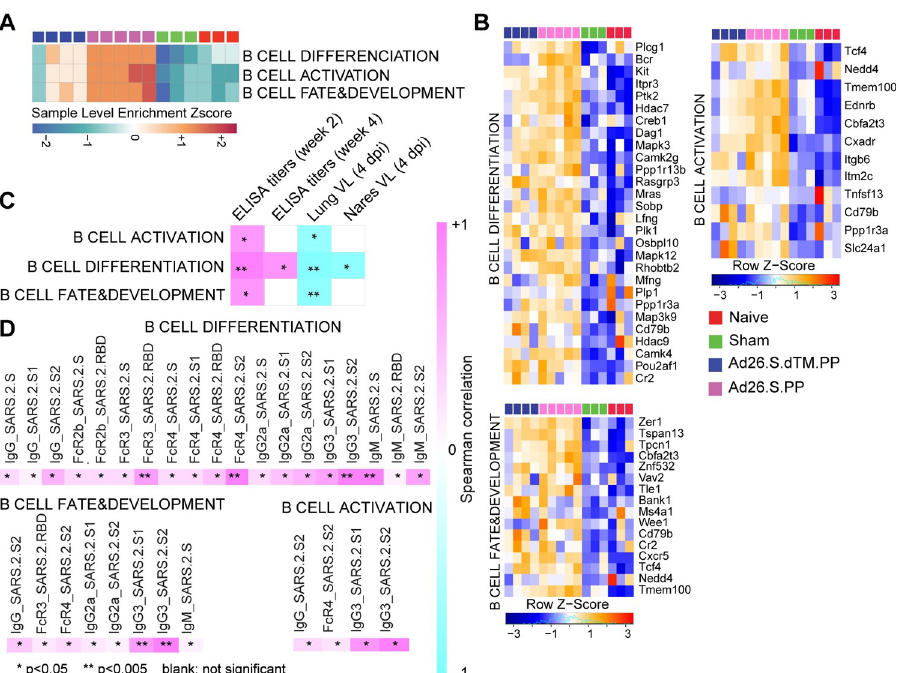
Fig 6. Pathways of B cell increased in Ad26.COV2.S vaccinated compared to na ï ve and sham hamsters. (A ) Sample-enrichment analysis (SLEA) of pathways of B cell activation, differentiation and B cell fate increased in vaccinated animals at 4 dpi (in pink and blue) compared to na ï ve and sham animals (in red and green). Heatmap presenting the SLEA z-score of each of these pathways. SLEA represents the mean expression of all significant genes within each pathway for each animal. (B ) Heatmaps of the leading genes of B cell markers from pathways shown in the top panel increased at 4 dpi in vaccinated compared to sham and na ï ve hamsters. Adjusted P-values ( < 0.05) were calculated by DEseq2 using Benjamini-Hochberg corrections of Wald test p-values. Columns correspond to individual animals, and rows correspond to particular gene normalized reads count scaled across all animals. (C) Matrix showing the spearman correlation of B cell signatures at 4 dpi with viral loads in hamster’s lung and nares, and with neutralizing and binding antibody titers at weeks 2–4 in vaccinated hamsters. Negative correlations were shown in cyan, and positive correlations were shown in pink. (D) Matrix showing the Spearman correlations of B cell pathways with S- specific and RBD-specific antibody responses in the Ad26.COV2.S vaccinated animals at week 4 by systems serology, including IgG, IgG2a, IgG3, IgM, Fc-receptors FcR γ 2, FcR γ 3, FcR γ 4, and antibody-dependent complement deposition (ADCD). All positive correlations were shown in pink. Correlations were assessed using Spearman